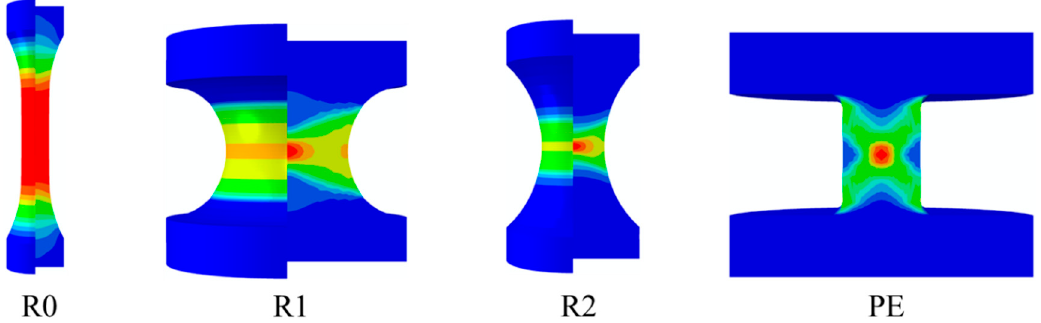
Figure 13. Comparison of specimens’ damage accumulation localization under different stress states during cyclic loadings. The contour plot shows high accumulation damage within the specimens during ELCF.